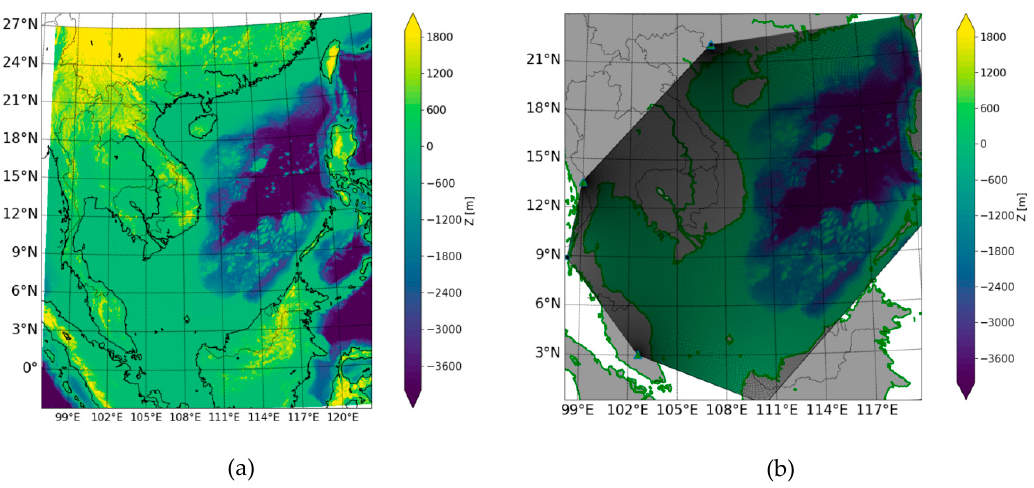
Figure 3. ( a ) The domain of the grid and bathymetry. ( b ) Grid for the South China Sea and coastal areas of Vietnam.